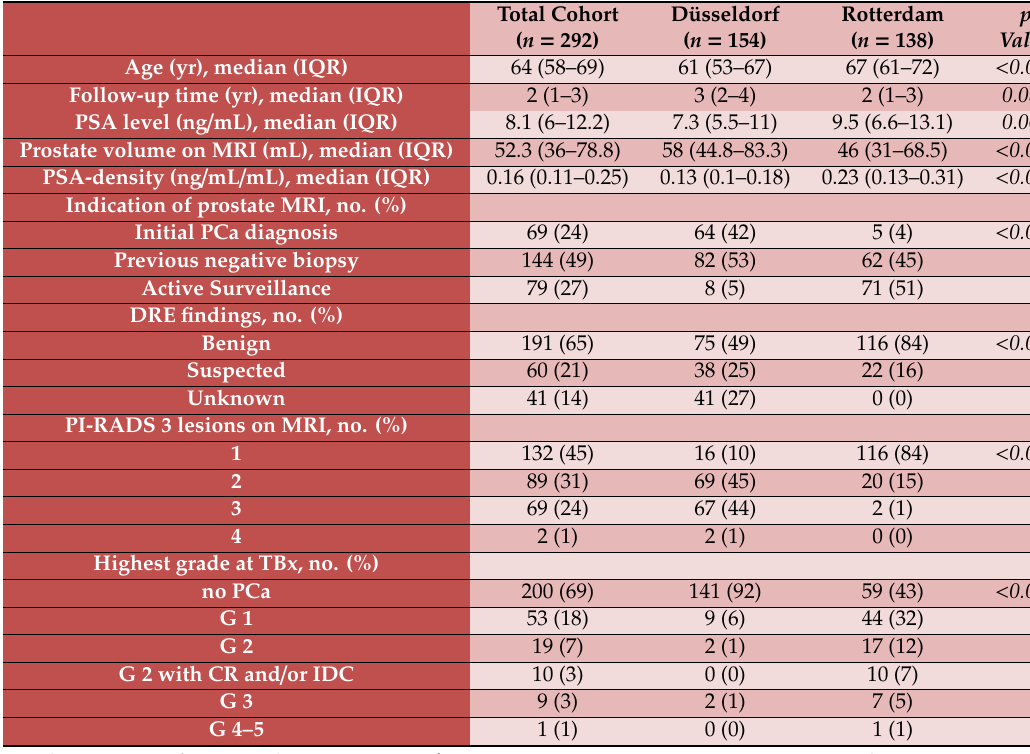
Table 1. Patient